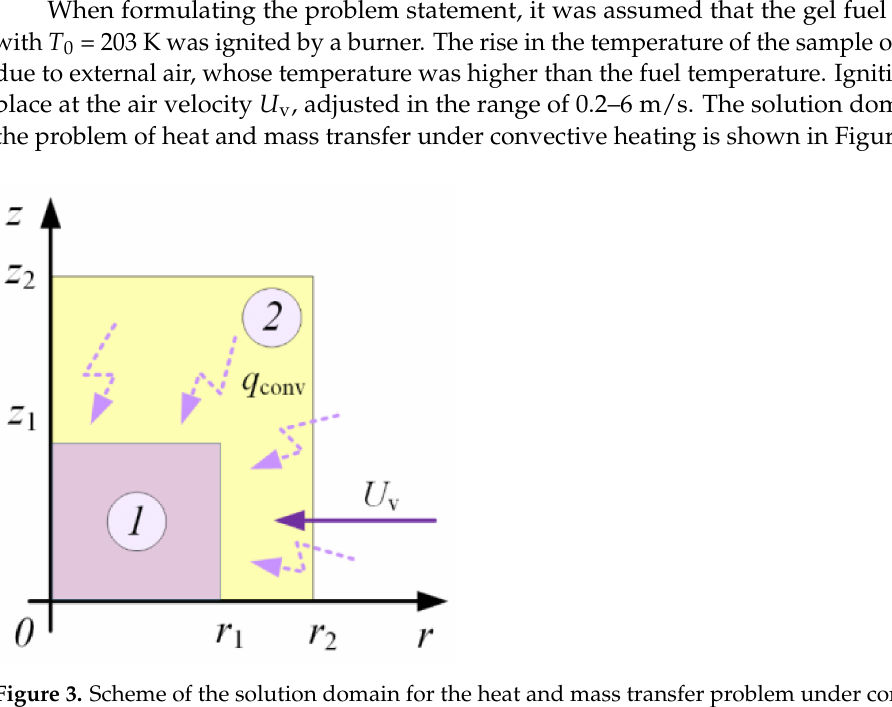
Figure 3. Scheme of the solution domain for the heat and mass transfer problem under convective heating: 1—gel fuel sample;